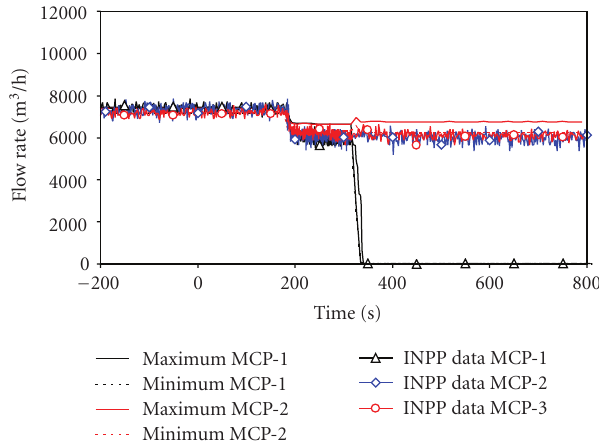
Figure 13: Three MCPs sequential trip. MCPs throughput in the intact MCC